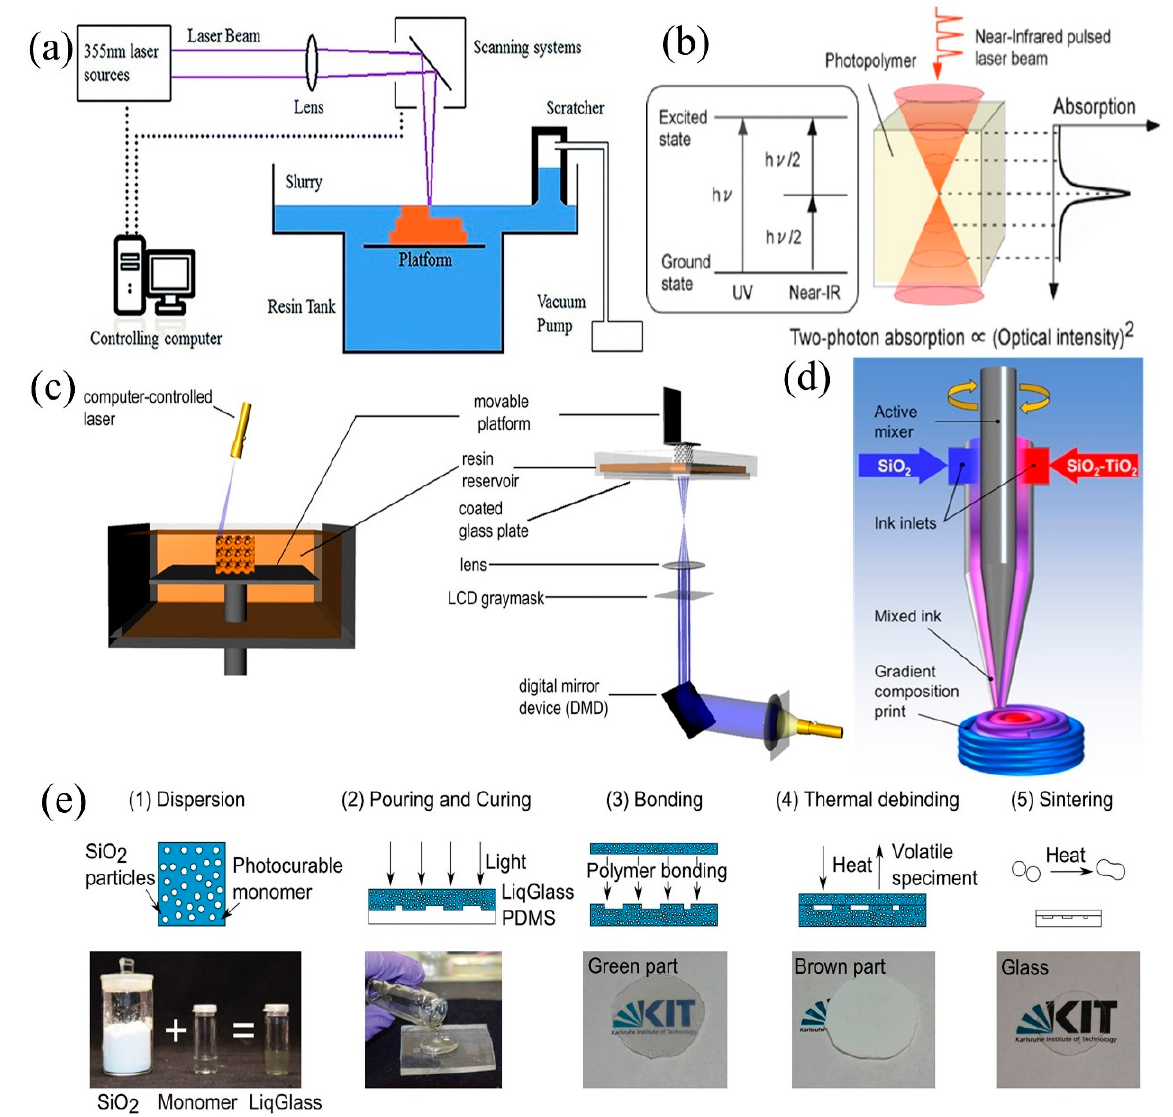
Figure 1. Schemes for ( a ) SLA [39], ( b ) TPP, ( c ) DLP, ( d ) DIW [14], and ( e ) sheet lamination. ( 1 ) ( 2 ) ( 3 ) ( 4 ) and ( 5 ) in ( e ) represent each step of the sheet lamination process. ( b ) Reprinted with permis- sion from ref. [40]. ( c ) Reprinted with permission from ref. [41]. ( e ) Reprinted with permission from ref.